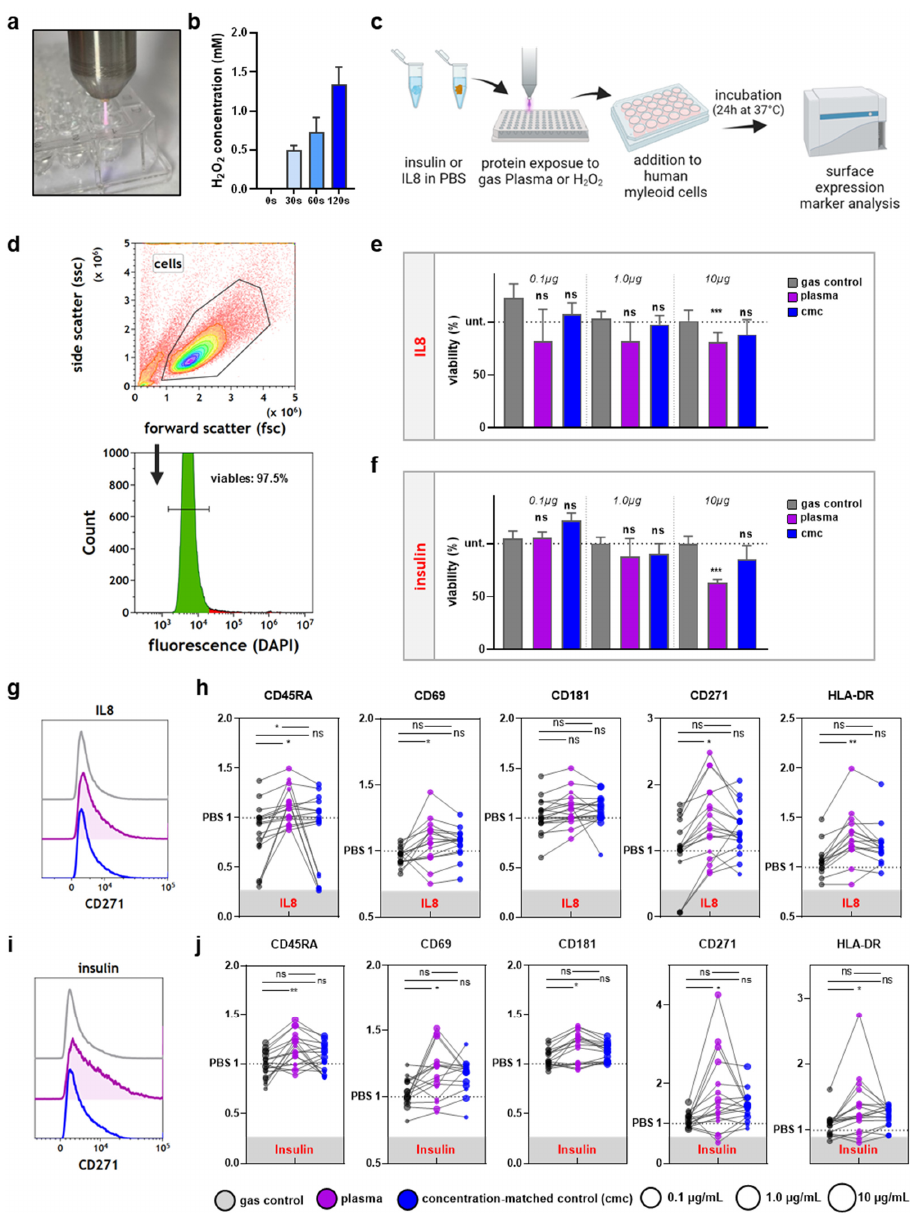
Figure 2. Gas plasma but not cmc-treated IL8 and insulin stimulates THP-1 cells. ( a ) Representative image of gas plasma treatment; ( b ) H 2 O 2 concentration measured after exposure to gas plasma—the 30 s concentration was used as the cmc in subsequent experiments; ( c ) workflow for THP-1 incubation with native or oxidized proteins; ( d ) representative strategy of flow cytometry analysis; ( e , f ) quantified and normalized data of cell viability after incubation with native or oxidized IL8 ( e ) or insulin ( f ) concentrations; ( g , h ) representative histogram ( g ) and quantification of surface marker expression after incubation with native or oxidized IL8 ( h ); ( i , j ) representative histogram ( i ) and quantification of surface marker expression after incubation with native or oxidized IL8 ( j ). Data show individual technical replicates of an assay with three independent experiments. Data are the mean of at least three independent experiments. Statistical analysis was performed using one-way analysis of variances of gas plasma and H 2 O 2 conditions against PBS (rhombi) or Mann–Whitney tests to compare gas plasma vs. H 2 O 2 (asterisks); for ANOVA: F = 1.9 (0.1)/4.4 (1.0)/10.4 (10) and df = 2 ( e ); F = 3.4 (0.1)/2.4 (1.0)/23.0 (10) and df = 2 ( f ); F = 0.7 (CD181)/4.9 (HLA-DR)/4.2 (CD271)/ 4.4 (CD45RA)/4.0 (CD69) and df = 2 ( h ); F = 3.2 (CD181)/3.2 (HLA-DR)/4.2 (CD271)/ 6.1 (CD45RA)/ 4.1 (CD69) and df = 2 ( j